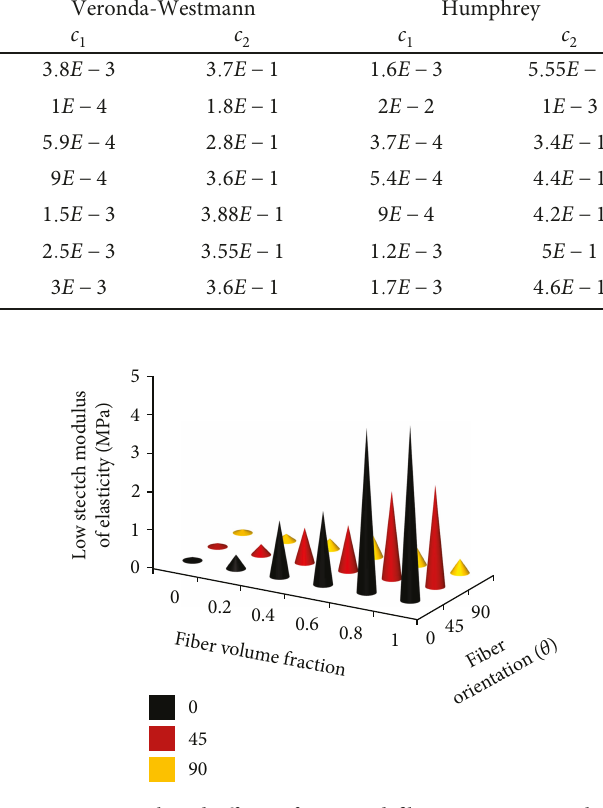
Figure 6: Combined e ff ects of FVF and fi ber orientation on low stretch modulus values of soft composite